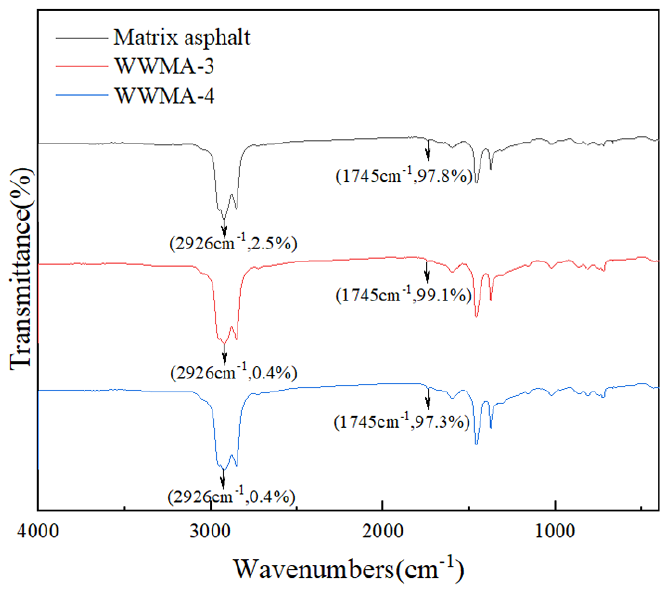
Figure 16. The FTIR spectra of matrix asphalt, WWMA-3 and WWMA-4. The peak at 1745 cm − 1 and 2926 cm − 1 is ascribed to the carbonyl group and methylene [41,42]. The relative transmittances of the carbonyl group of matrix asphalt, WWMA-3, and WWMA-4, are 39.12, 247.75, and 243.25, respectively. It indicates the relative